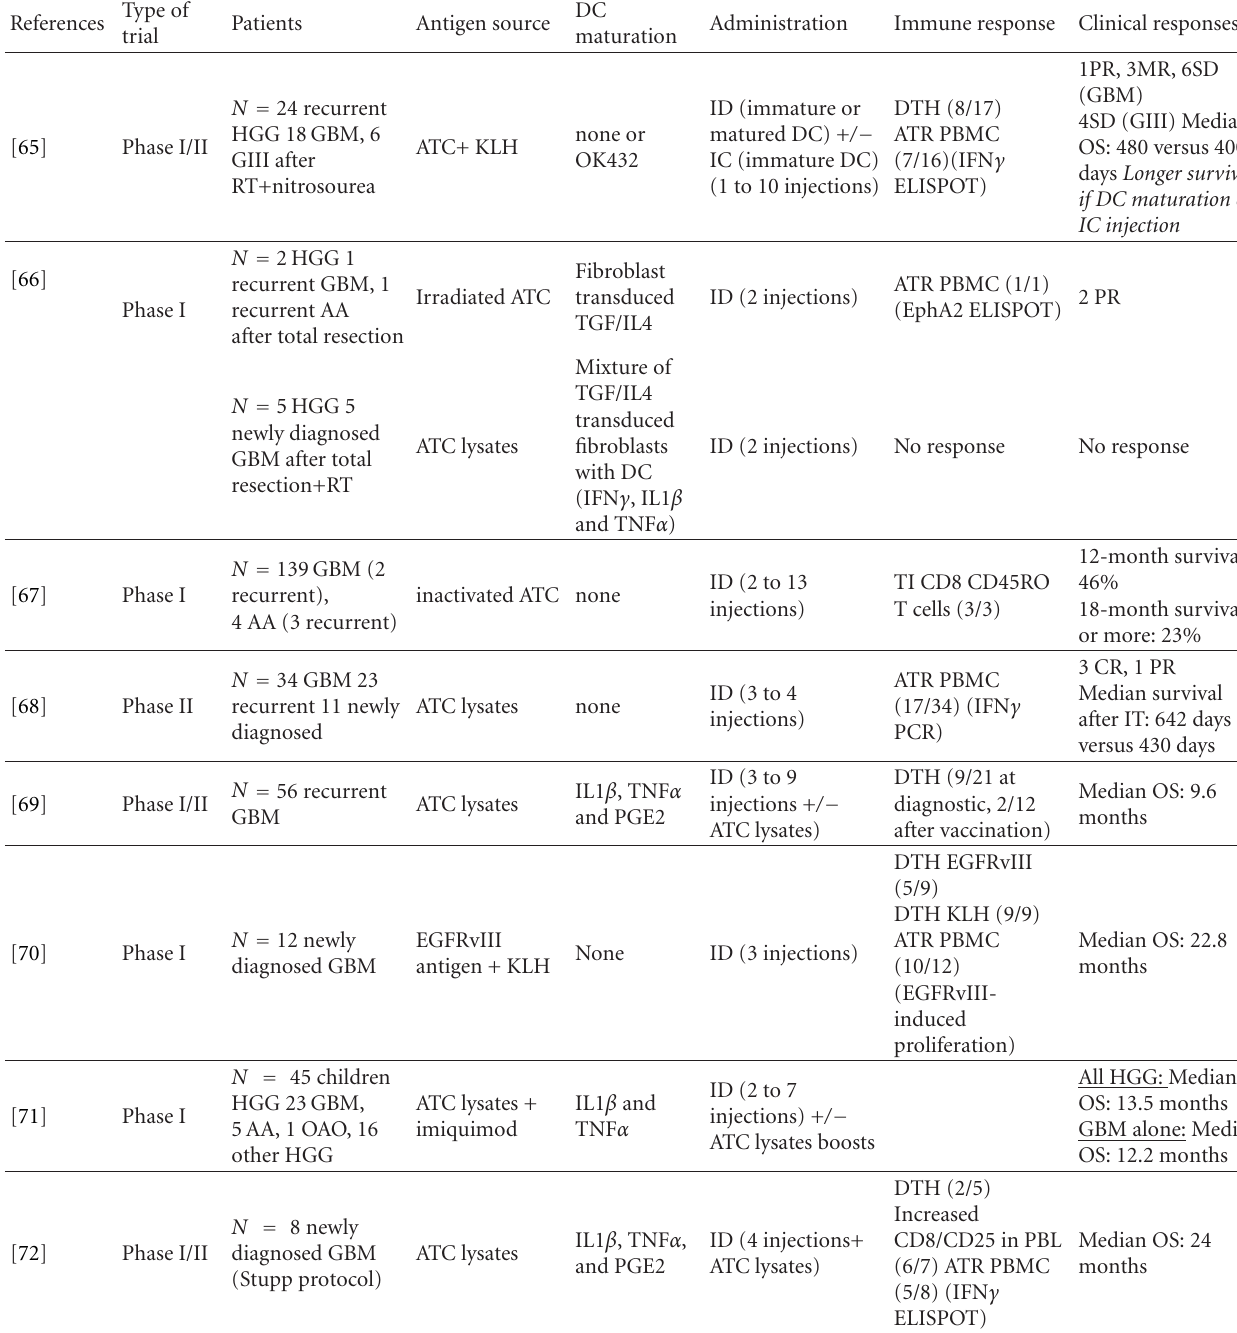
∗ : Abbreviations used in this table: see Table1 to Table 3; KLH: keyhole limpet haemocyanin;PXA: pleomorphic xanthoastrocytoma; XA: xanthoastrocytoma.